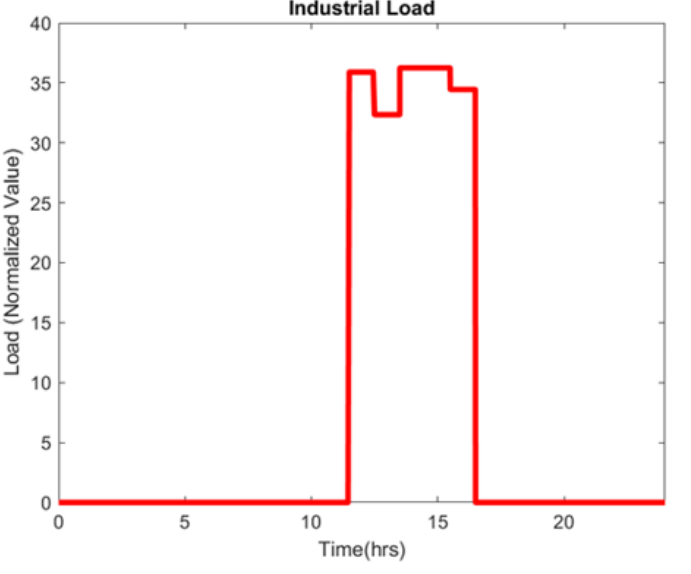
Figure 13. Operation of CPP.